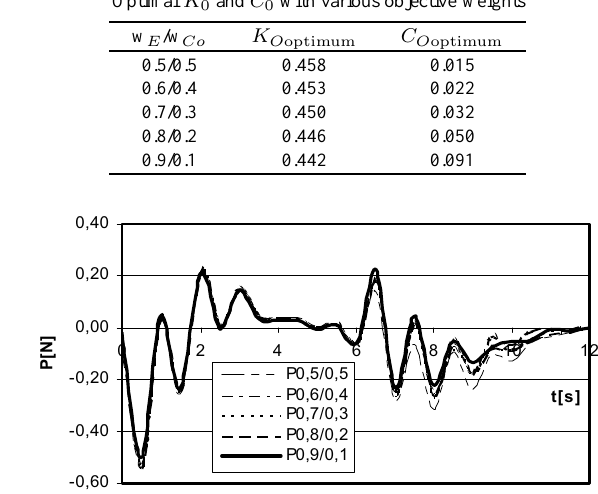
Table 1 Optimal K 0 and C 0 with various objective weights